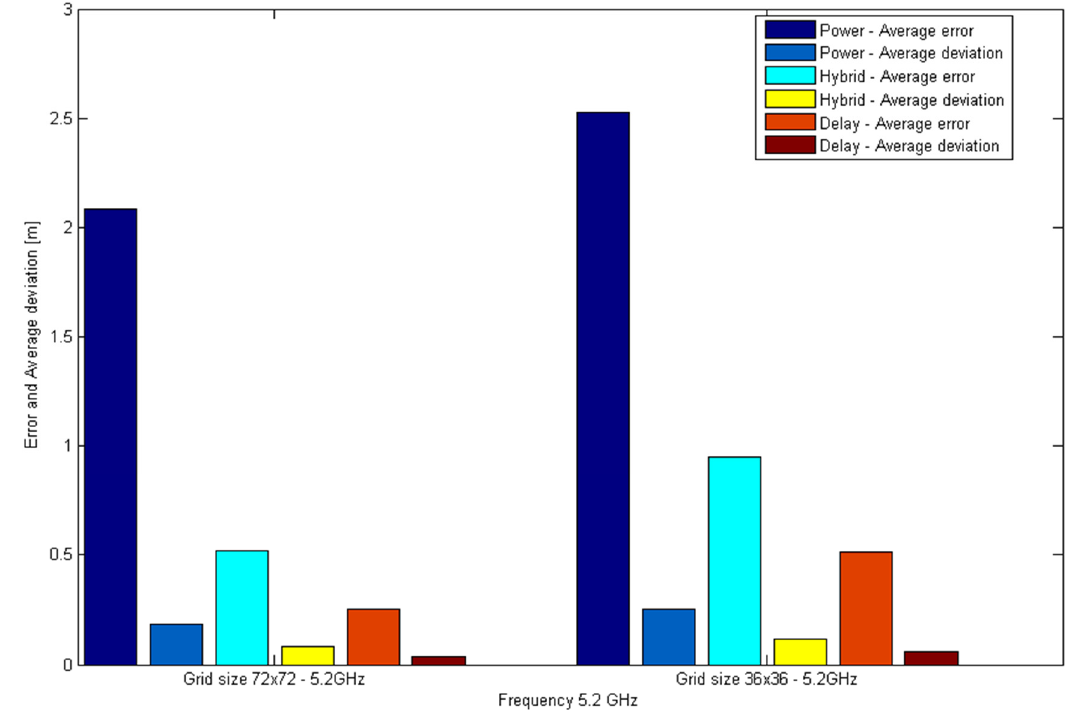
Figure 11. Detection methods comparison: Power, delay and hybrid detection at a frequency of 5.2 GHz.